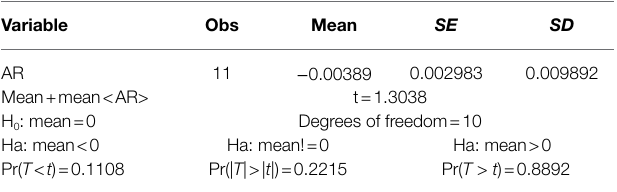
TABLE 16 | Changes in abnormal